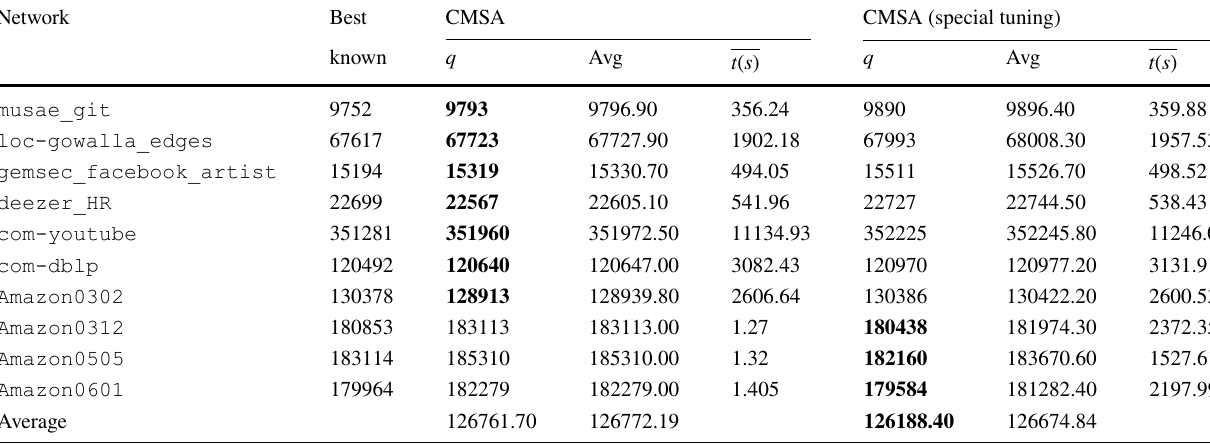
Table 4 Results of CMSA after specific tuning for the large SNAP networks